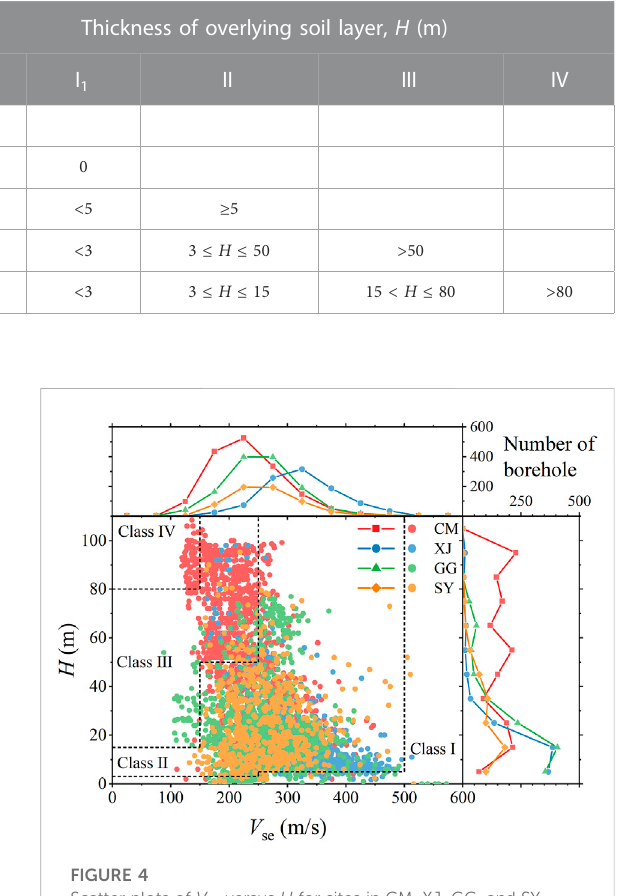
FIGURE 3 Proportions of borehole sites associated with different site classes in SY, XJ, GG, and CM.